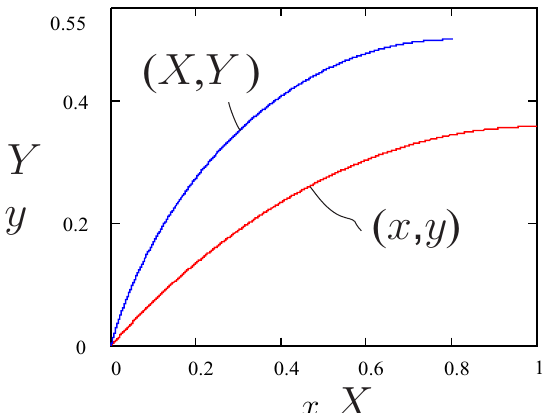
Figure 3. Post-critical shape of optimally shaped rod X , Y and x = t , y , where ˙ y = ϑ , and ϑ is the eigenfunction of (12) and